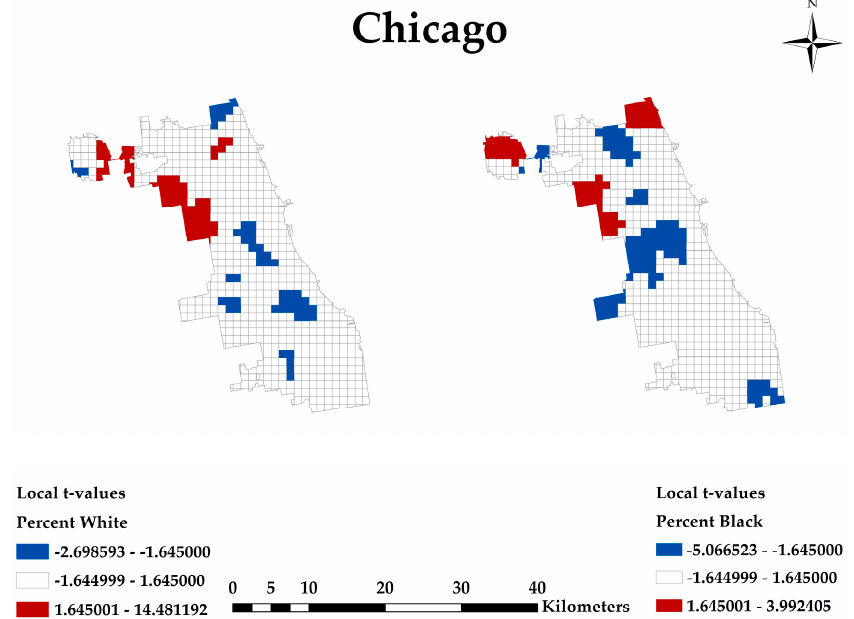
Figure 8. Chicago shrinking city Percent White and Percent Black: 95% two-tailed test ( − 1.96:1.96).